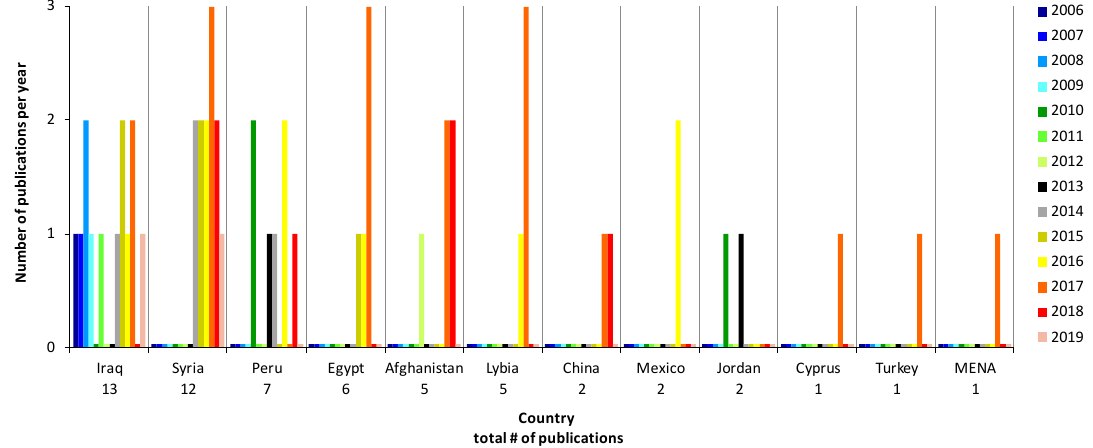
Figure 3. Geographic and temporal distribution of documented looting in the peer-reviewed publications of Figure 2. Publication database updated as of June 2019.